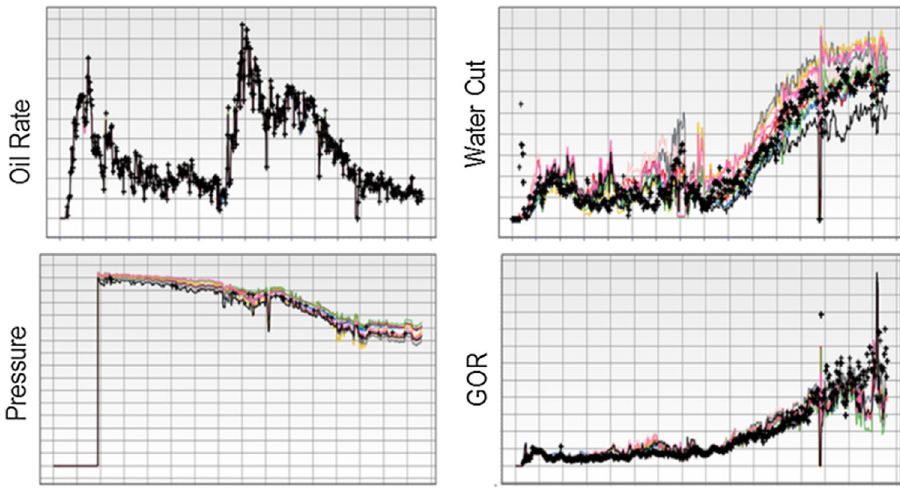
Fig. 12 Shows field oil rate, water cut, pressure, and GOR simulated vs. observed data